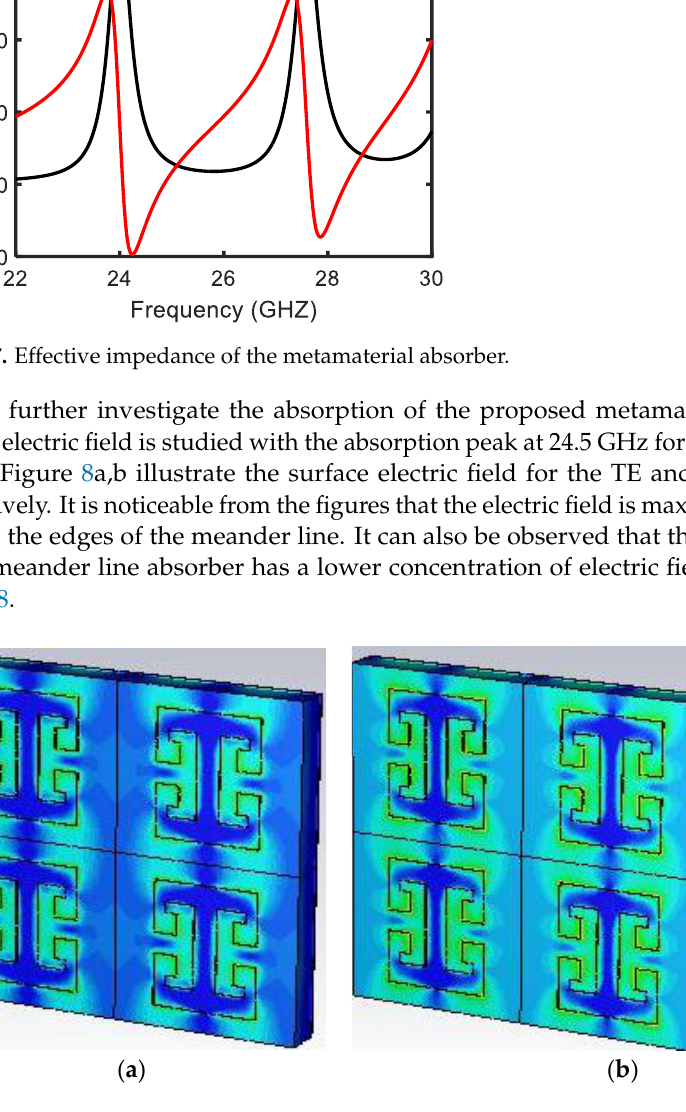
Figure 8. Simulated electric field distribution for 24.5 GHz for ( a ) TE polarized wave and ( b ) TM polarized wave.